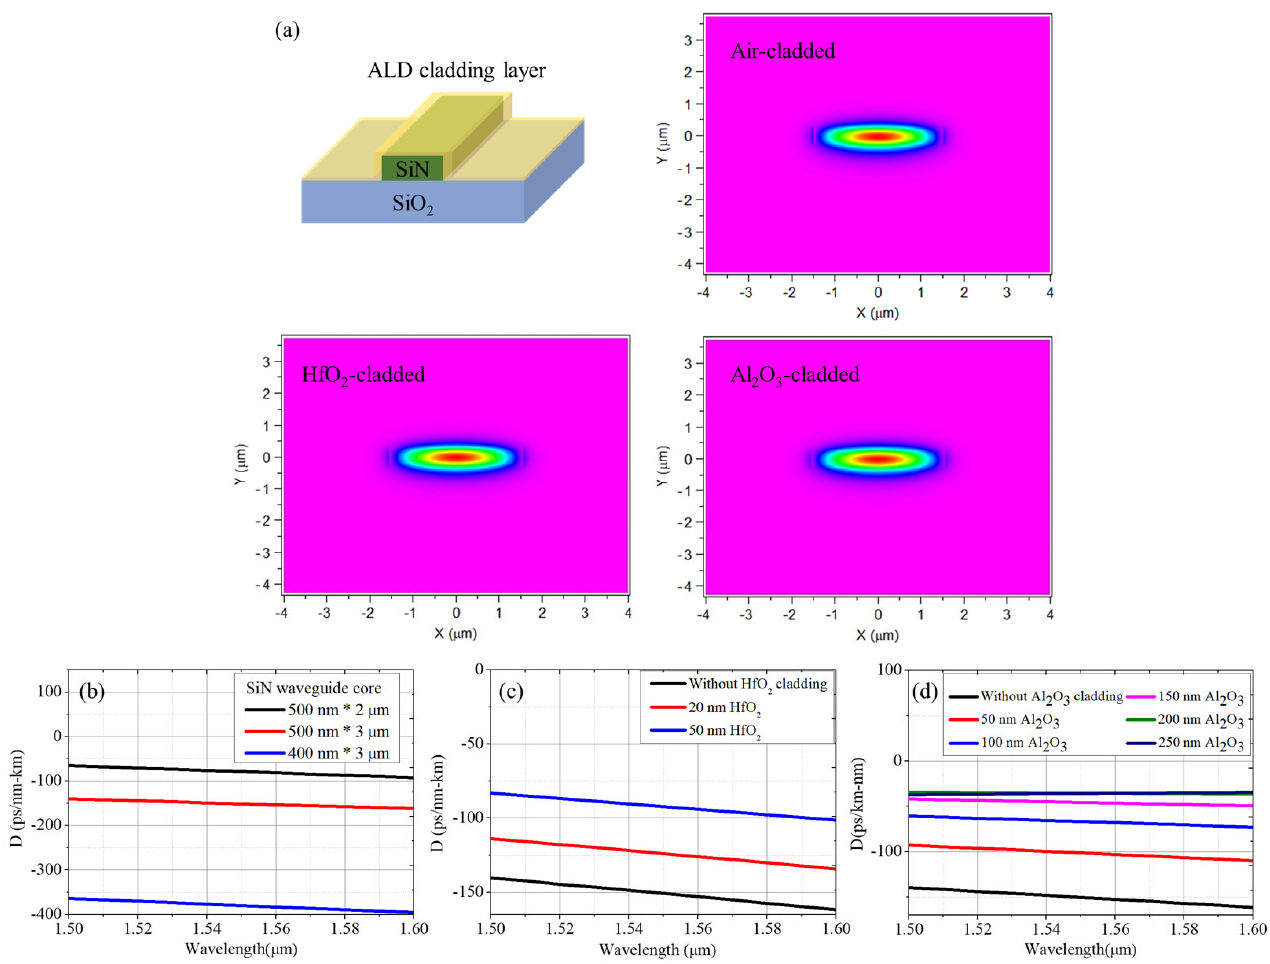
Figure 1. ( a ) Field profiles of the air-cladded and 50 nm ALD-cladded SiN waveguides with a cross- section of 500 nm × 3 µm. Waveguide dispersion at around 1550 nm versus the thickness of ( b ) air cladding, ( c ) HfO 2 ALD cladding, and ( d ) Al 2 O 3 ALD